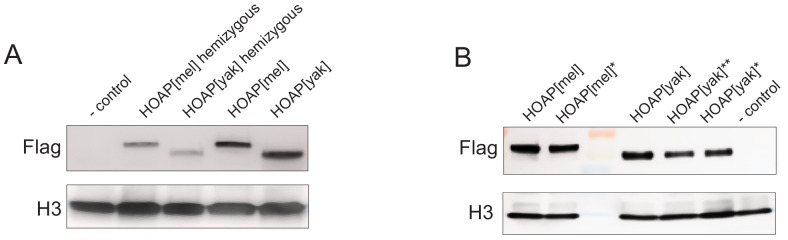
Western Blots of ovaries probed with anti-H3 (control) and anti-Flag to detect Flag-tagged HOAP.(A) Ovaries hemizygous or homozygous for the transgenes (B) '*' Ovaries from homozygous genotypes used in replicated experimental evolution, '**' genotype not included in downstream experiments.